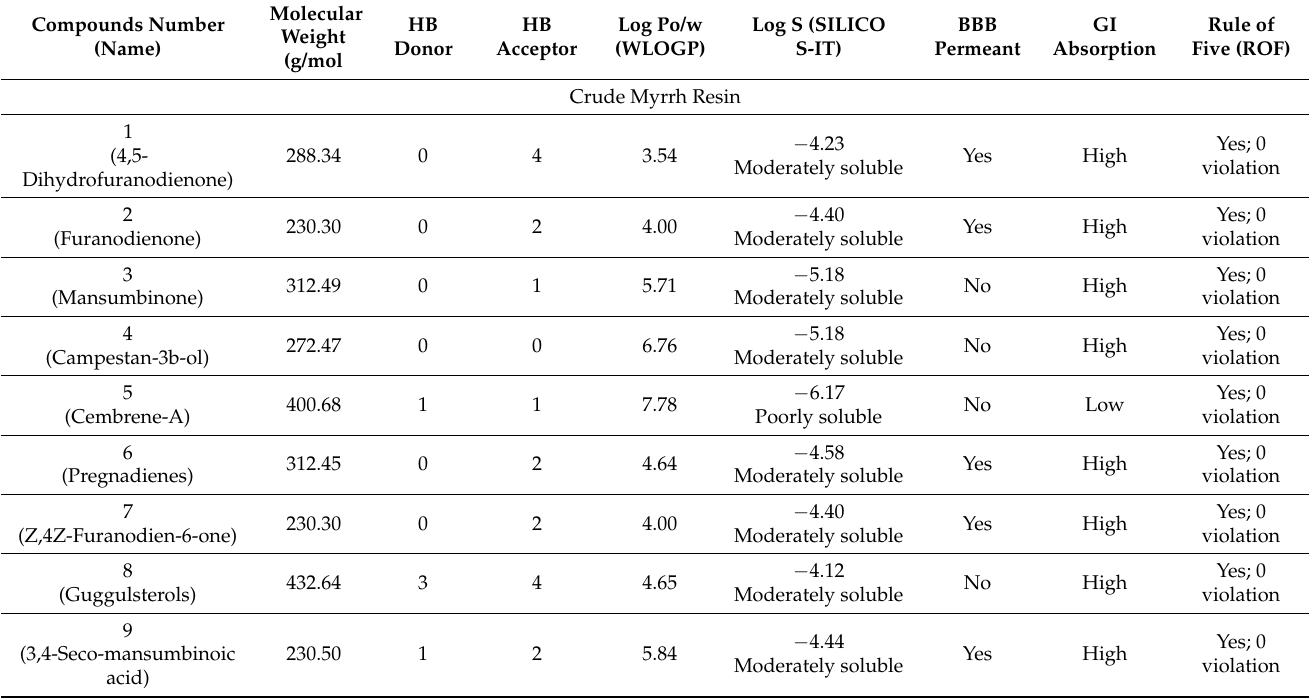
Table 6. Predictions of the pharmacokinetics ADME properties of crude myrrh resins using Swis- sADME computational